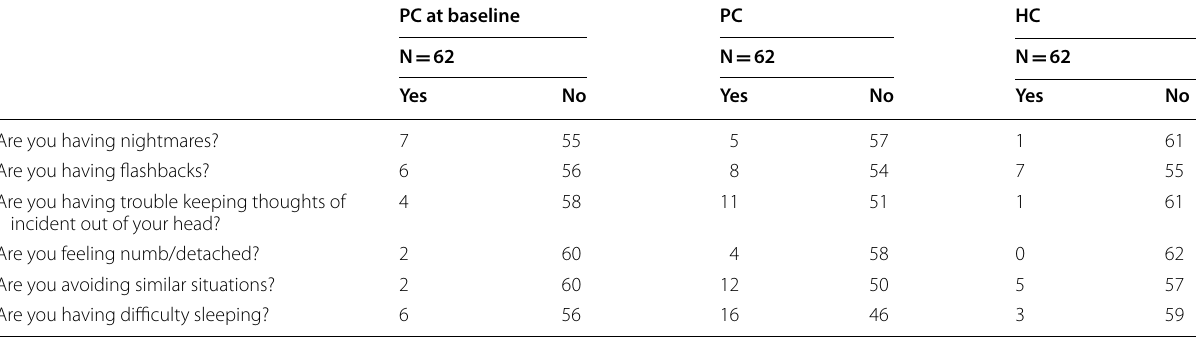
Table 6 Frequency for each of PTSD questions